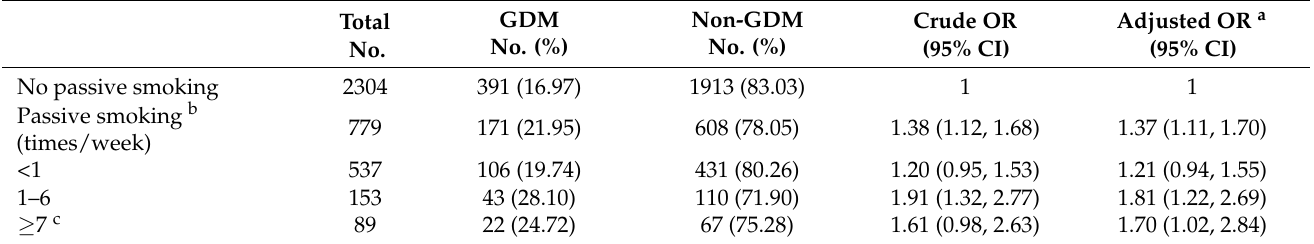
Table 2. Passive smoking and incidence rate of GDM.